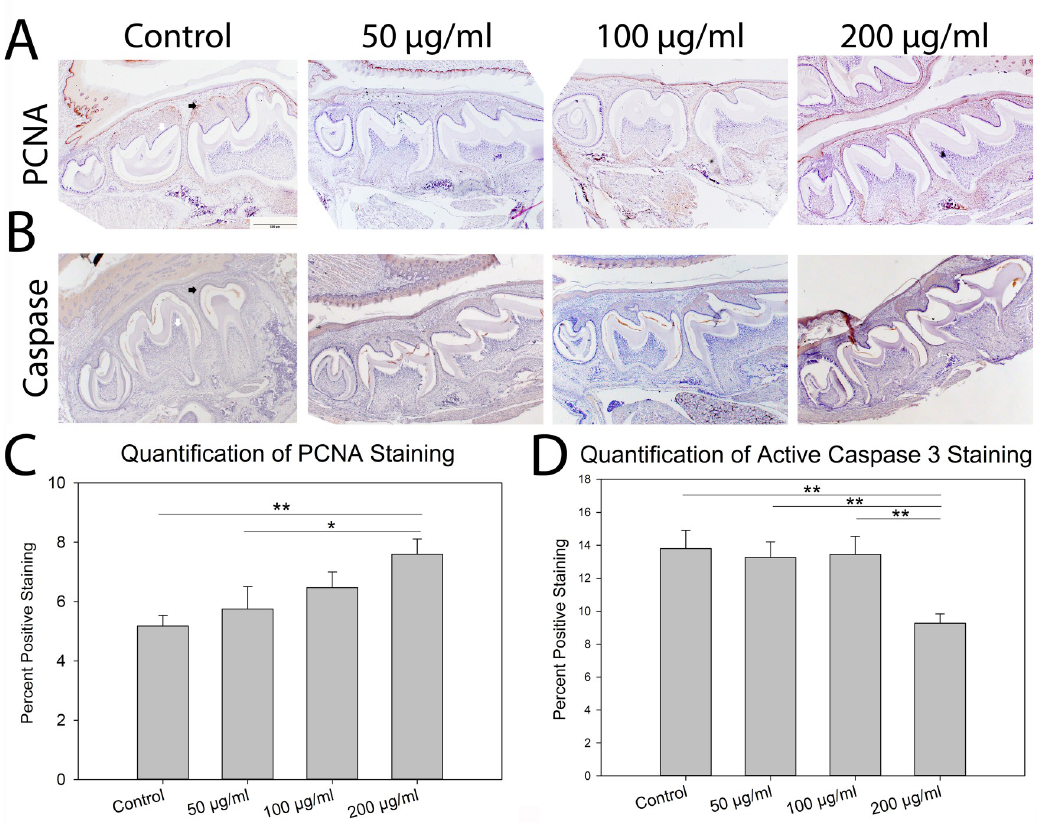
Fig 4. Cell proliferation and death in mandibular molars. A-B) Representative histological images of mandibular molars stained for Proliferating Cell Nuclear Antigen (PCNA, A) and Active Caspase 3 (Caspase, B) from individuals exposed to 0 μ g/ml (control), 50 μ g/ml (low), 100 μ g/ml (medium), or 200 μ g/ml (high) nicotine in utero . Black horizontal arrows indicate positive staining and white vertical arrows indicate negative cells for each target. C) Quantification of percent of positive staining within the area of interest surrounding the molars ( Fig 2B ) indicates increasing proliferation with nicotine exposure. D) Apoptosis as indicated by positive caspase staining was reduced in the area of interest surrounding the molars in individuals exposed to high dose nicotine as compared to control and all other nicotine doses. n = 4 per exposure Scale Bar = 500 μ m. � p < 0.05 �� p <